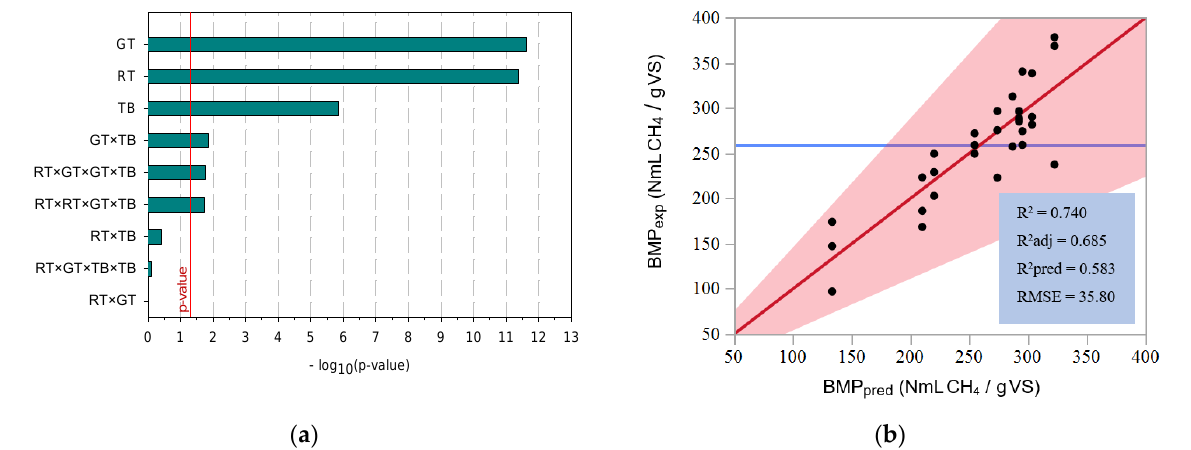
Figure 4. ( a ) Statistical significance of the terms included in the complete special quartic model. ( b ) Comparison between predicted and experimental BMP values obtained from the mixture design.